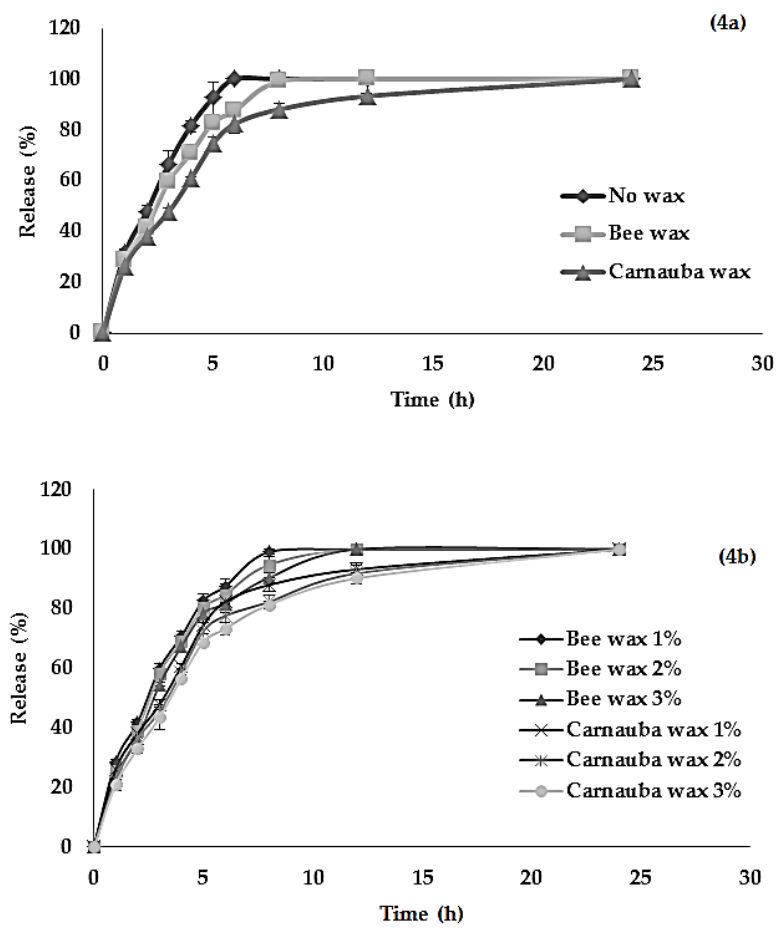
Figure 4 . Effect of types ( 4a ) and amounts ( 4b ) of waxes on the percentage of active release from alginate gel beads containing tamarind seed extract .